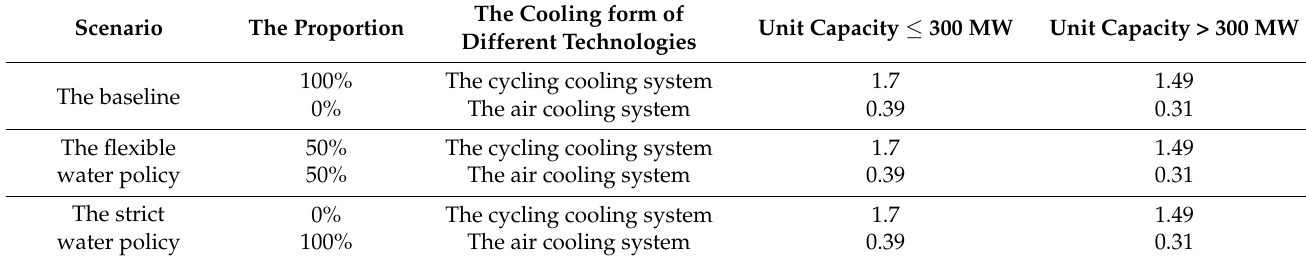
Table 6. The water consumption factor under three water policy scenarios.